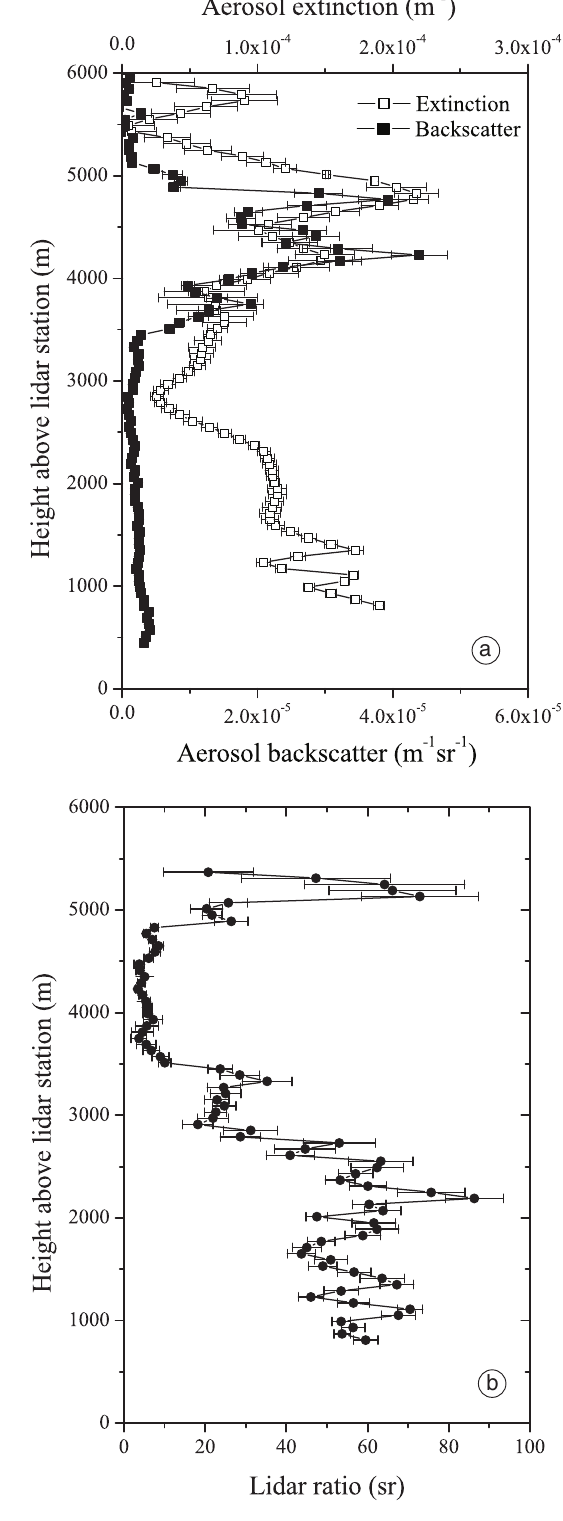
Fig. 2. Vertical profi les of the aerosol backscatter at both 355 nm (solid squares) and 532 nm (open cir- cles) measured in Tito Scalo on 20 September 2000 (19:56-20:27 UTC).